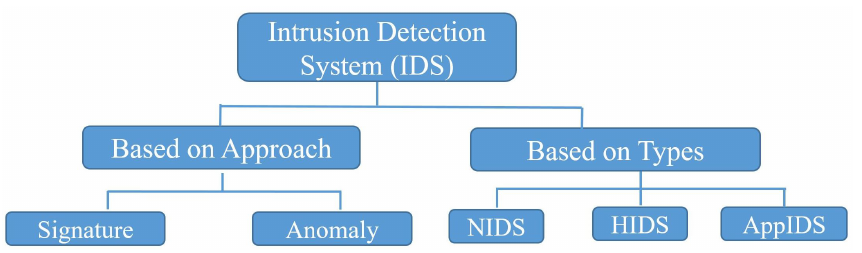
Figure 10. Intrusion detection system